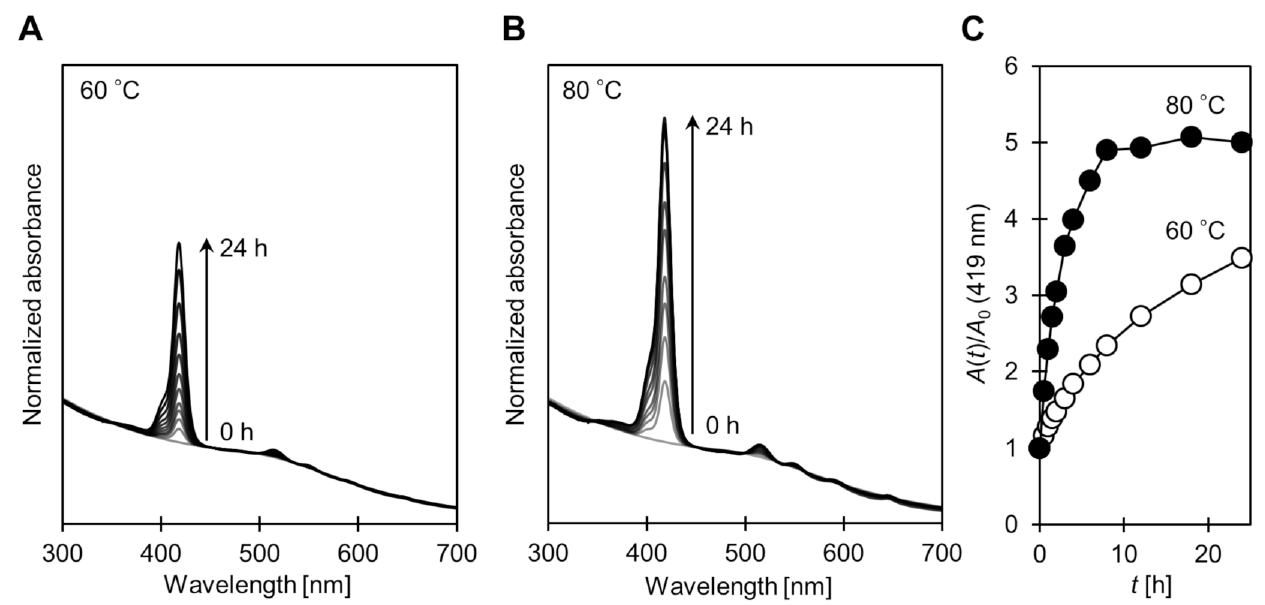
Figure 1. Change in UV–vis absorption spectra on disulfide/thiolate ligand exchange reaction between 1 and 2 @AuNP at ( A ) 60 ◦ C and ( B ) 80 ◦ C. Conditions: [ 1 ] 0 = 2.95 mmol/L, [ 2 @AuNP] 0 = 0.48 mmol/L. Spectra were normalized at 450 nm where absorption of porphyrin is negligible. ( C ) Relative absorbance of Soret band (419 nm):